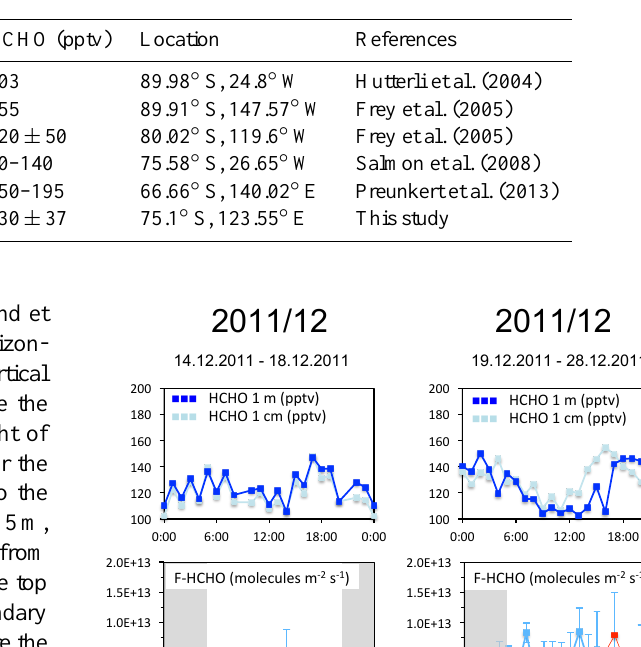
Table 2. Atmospheric HCHO mixing ratios in the lower Antarctic atmosphere.